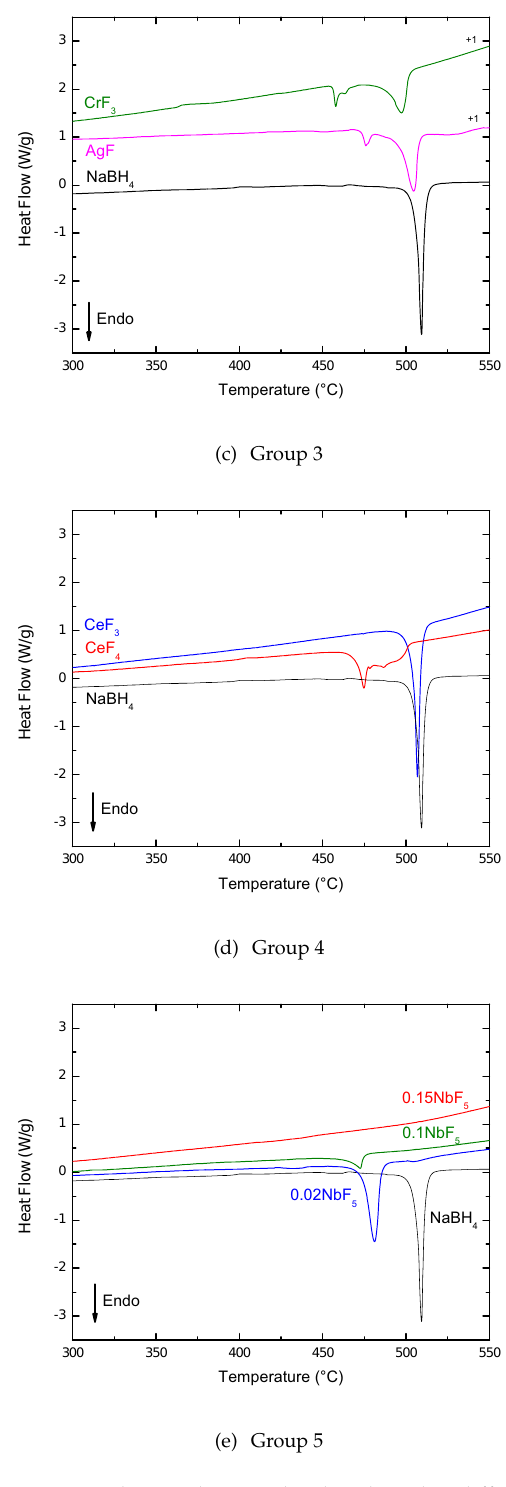
Figure 3. DSC-Setaram corresponding to the samples distributed in different groups based on their behavior. The numbers on the right-hand side indicate the shift applied to the data for